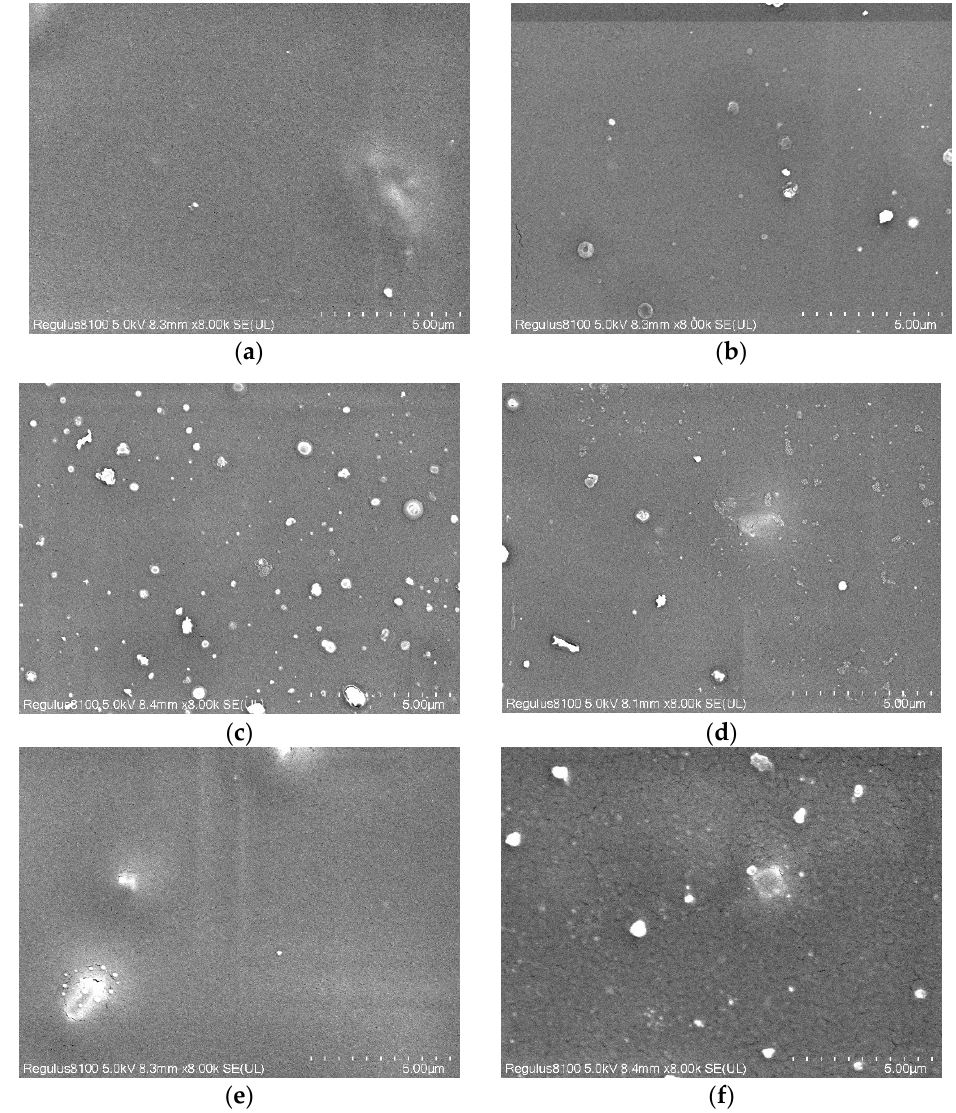
Figure 11. SEM images of PLA ( a ) and PLA/zeolite composites magnified 8000 times with different zeolite concentrations: ( b–f ) shows 2, 4, 6, 8 and 10 wt%, respectively.